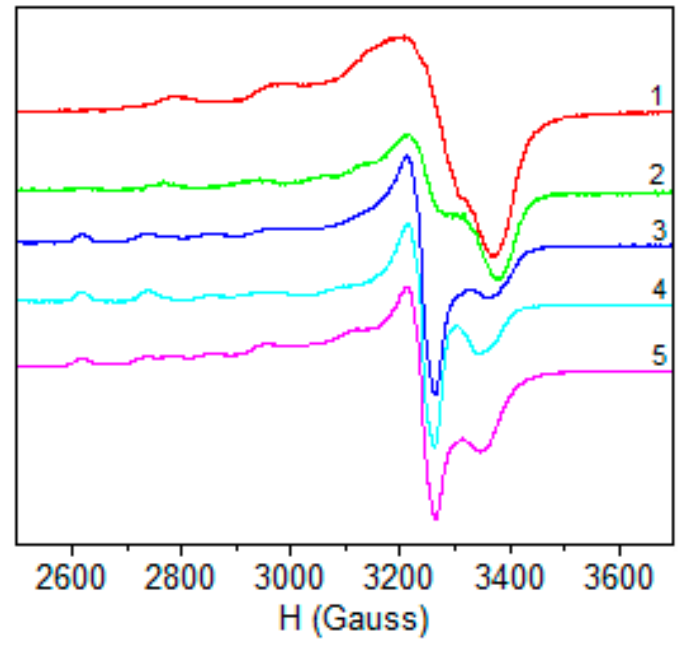
Figure 5. EPR spectra of complexes 1 – 5 in DMSO solution at 77 K.